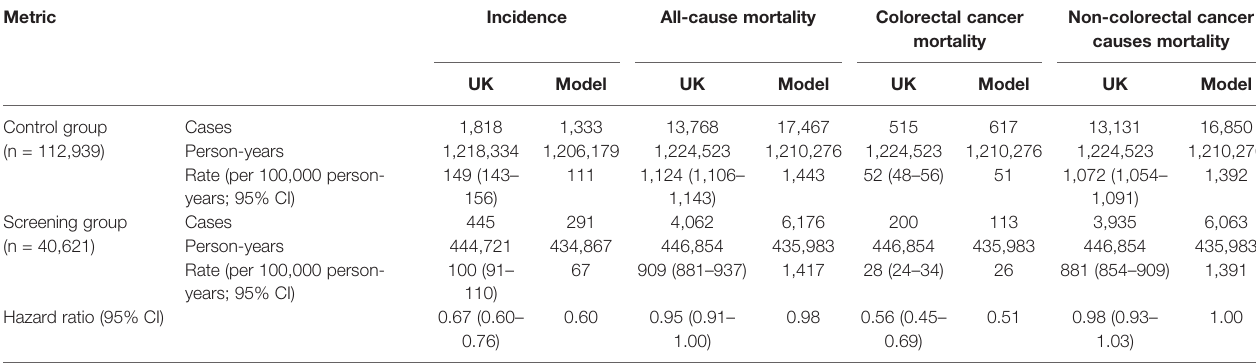
TABLE 1 | Comparison of model-predicted outcome and the reported results in the UK Flexible Sigmoidoscopy Trial.